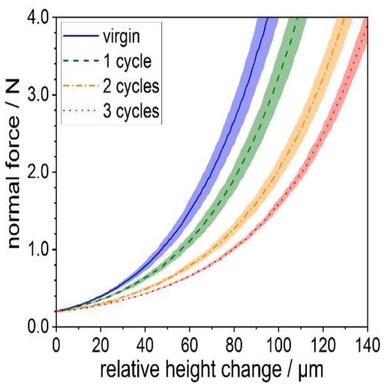
Rise in normal force in virgin and processed polyamide 12 powder bulks during compression by a constantly decreasing measurement cell height at 25 ◦C. Samples were consolidated by a normal force of 0.2 N before compression. Faded areas indicate the standard deviation over five measurements.